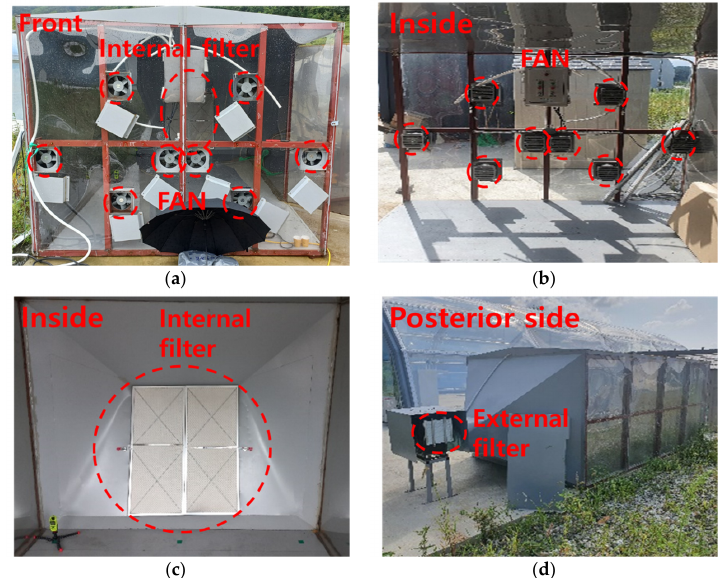
Figure 5. Enclosed chamber. ( a ) Front view, ( b ) fan, ( c ) internal filter, and ( d ) external filter .